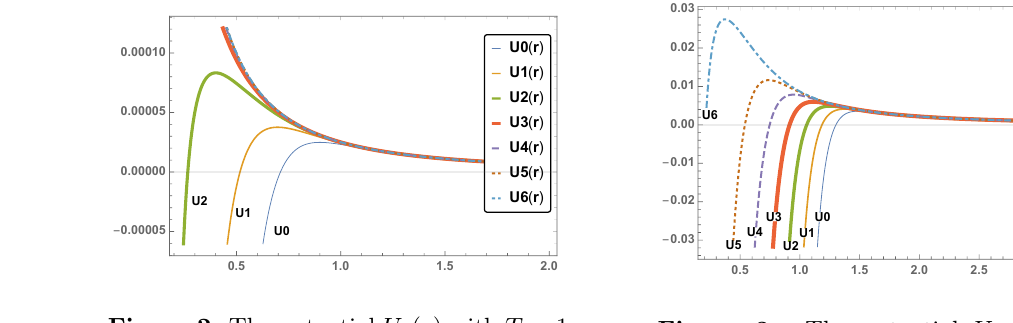
Figure 3 . The potential U N;p ( r ) with T p = 1, L = 0 : 01 and N =